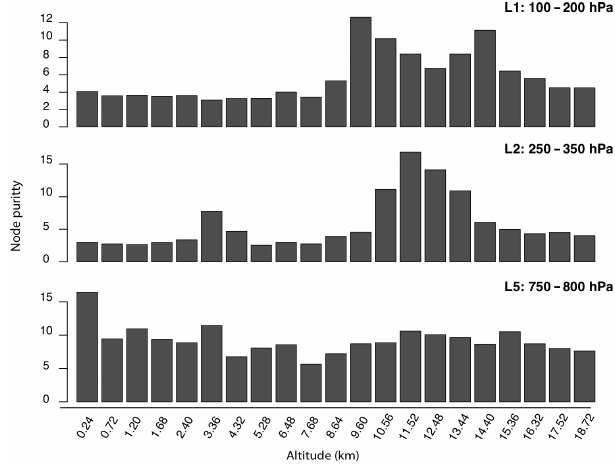
Figure 6. Variable importance (QRF method) for the predicted RH for ice cloud profiles ( k = 8) in the Indian Ocean, July